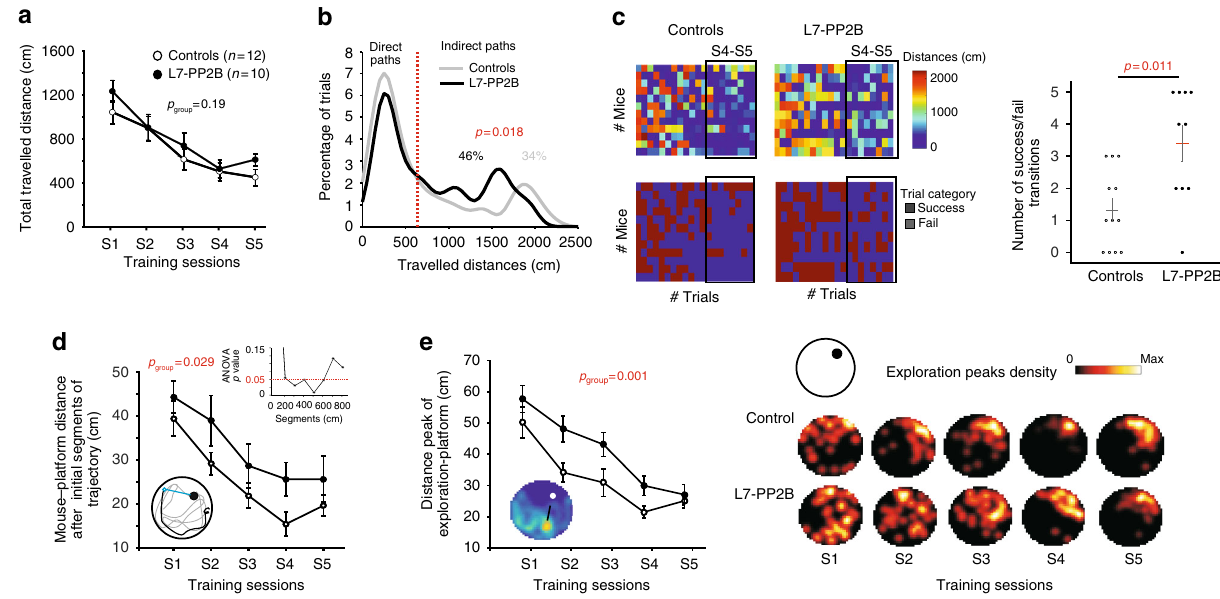
Fig. 6 L7-PPB mice orientation abilities are impaired in the Morris Water Maze. a Performance of control ( n = 12) and L7-PP2B ( n = 10) mice improved signi fi cantly along the training sessions (repeated measure ANOVA, session F (4,20) = 16.6, p < 0.001; genotype, F (1,20) = 1.8, p = 0.19; session*genotype interaction, F (4,20) = 0.4, p = 0.83). b Distributions of traveled distances of all trials for control (gray) and L7-PP2B (black) mice. The bimodal distribution allowed the separation of direct and indirect trials using a Gaussian fi t, the threshold is indicated by the red dashed line ( p = 0.018 with a Fisher exact test). c Left, Top. Color-coded representation of traveled distances for all trials. Each line represents the performances of one mouse over the training. Bottom. Same representation with the categorization in successful (direct, blue) and failed (indirect, brown) trials. Right, The number of transitions between successful and failed trials is higher in L7-PP2B mice compared to controls ( U = 22, p = 0.011, Mann – Whitney U -test) at the end of training (S4 and S5, indicated by the black frame on the left panel). d Mouse initial orientation is evaluated by the distance between mouse position and platform location after a 300 cm initial trajectory (repeated measure ANOVA genotype, F (1,20) = 5.6, p = 0.029; session, F (4,20) = 13.5, p < 0.001, session*genotype interaction, F = 0.2, p = 0.92). The cartoon illustrates a trajectory in gray, the initial segment in black and the mouse – platform distance in blue. Inset: ANOVA p (4,20) values for the same analysis performed for different lengths of initial trajectory segments showing that p < 0.05 from 200 to 600 cm lengths. e Left. Mean distance between the peak of exploration (corresponding to mouse search area) and the platform location (repeated measure ANOVA, genotype F (1,20) = 14.8, p = 0.001; session F (4,20) = 20.1 p < 0.001, genotype*session interaction, F (4,20) = 20.1, p = 0.54). The cartoon illustrates a map showing the platform (white circle), the peak of exploration (yellow), and the peak – platform distance (arrow). Right. Heat maps showing the spatial distribution of exploration peaks along the training. The cartoon indicates the platform location (black disk) in the pool (top left). See Supplementary Fig. 13 for a detailed description of the analyses. Error bars represent